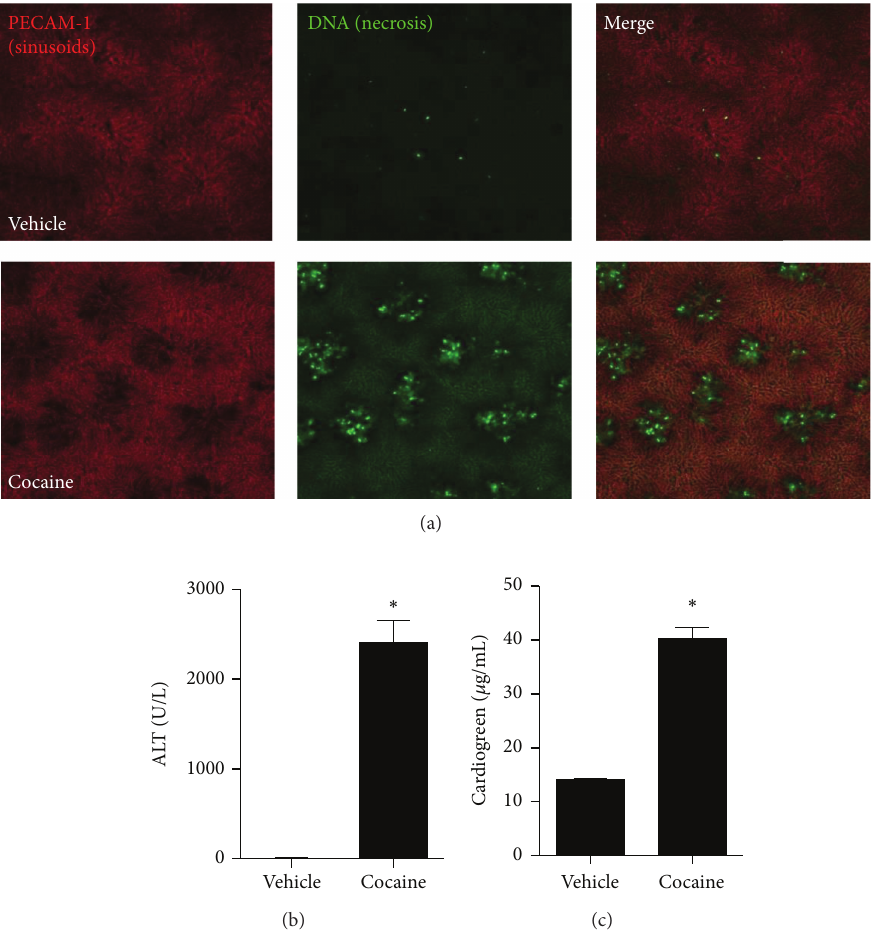
Figure 1: Cocaine intake causes severe liver injury and malfunction. (a) Liver confocal intravital microscopy showing that while control mice have a well perfused liver vasculature (evidenced by PE-anti-CD31 antibody staining, in red) and absence of necrosis (in green), cocaine- treated mice had several dark areas in the red channel, which are suggestive of malperfusion caused by necrosis (elicited by DNA staining using Sytox Green). (b) Serum liver transaminase levels and (c) retention of cardiogreen confirmed necrosis. ∗ Statistical significance in comparison to controls ( 𝑃 < 0.05 ). A 10x objective was used during imaging. One-way ANOVA with Tukey’s post hoc test. Data are expressed as mean ± S . E . M. ( 𝑛 = 6